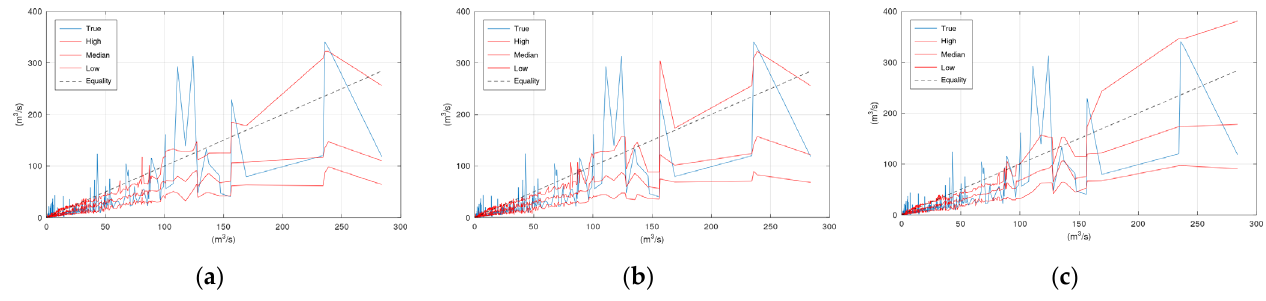
Figure A1. Scatter plot of the KNN application in the Arno River case study during the validation period: ( a ) 2D Option 1; ( b ) 2D Option 2; ( c ) 2D Option 3.